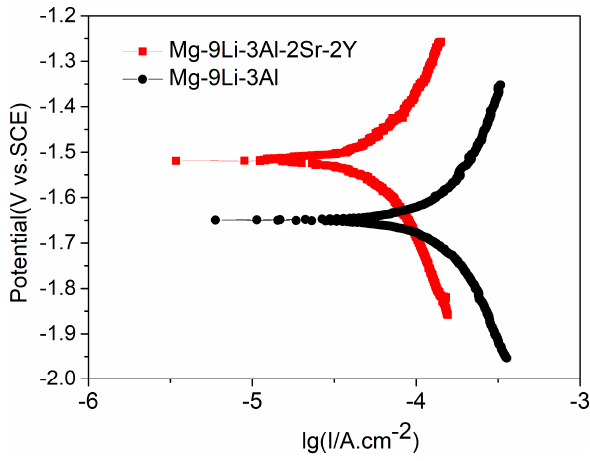
Figure 9. The open circuit potential (OCP)—Time curves of Mg-Li alloys in 3.5% NaCl solution.